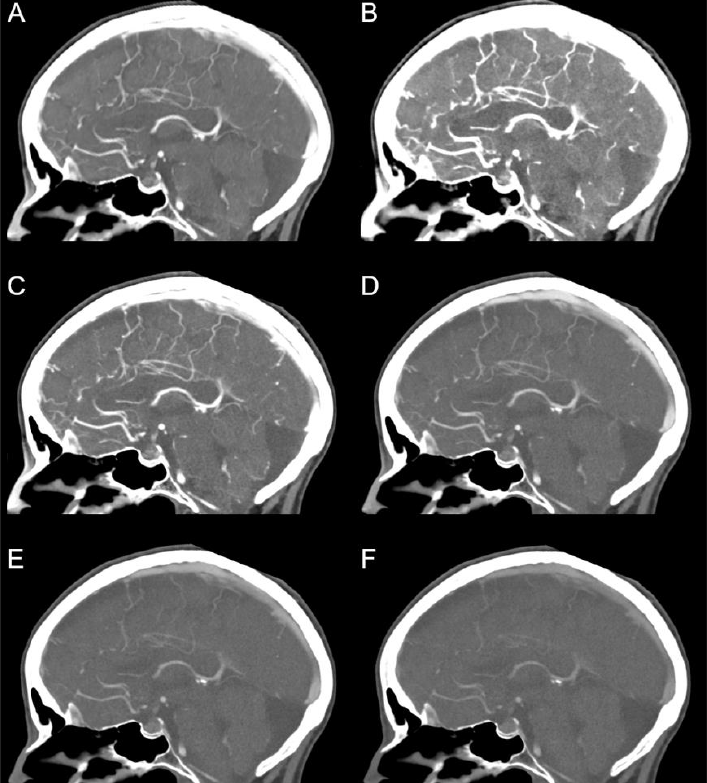
Figure 1. Polyenergetic and monoenergetic reconstructions. ( A ) polyenergetic reconstruction; mo- noenergetic reconstructions with ( B ) 40 keV, ( C ) 60 keV, ( D ) 80 keV, ( E ) 100 keV and ( F ) 120 keV. Window settings were identical in each image. Note the sharp visualization of the small intrasulcal vessels in the polyenergetic reconstruction ( A ).